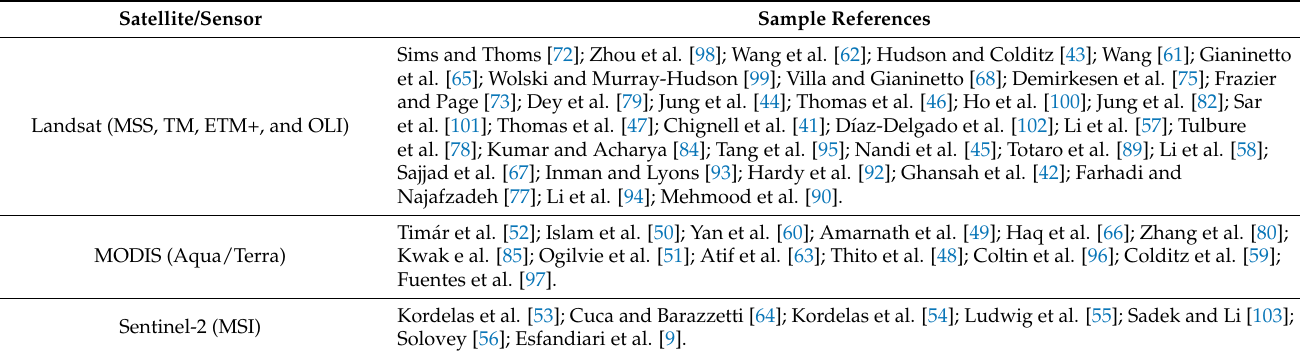
Table 2. Sample of references, in chronological order, for flooded area and wetland inundation mapping using Landsat, MODIS, or Sentinel-2